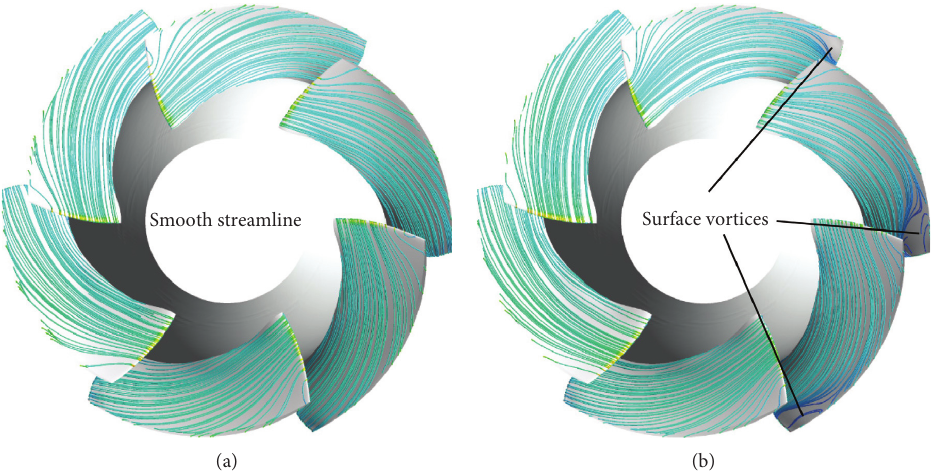
Figure 12: Streamlines on blade under 0.67 Q ′ condition: (a) original scheme; (b) selected